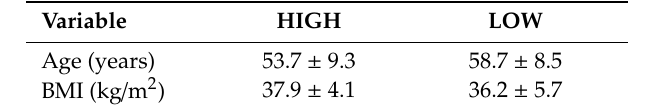
Table 1. General characteristics of participants before the intervention